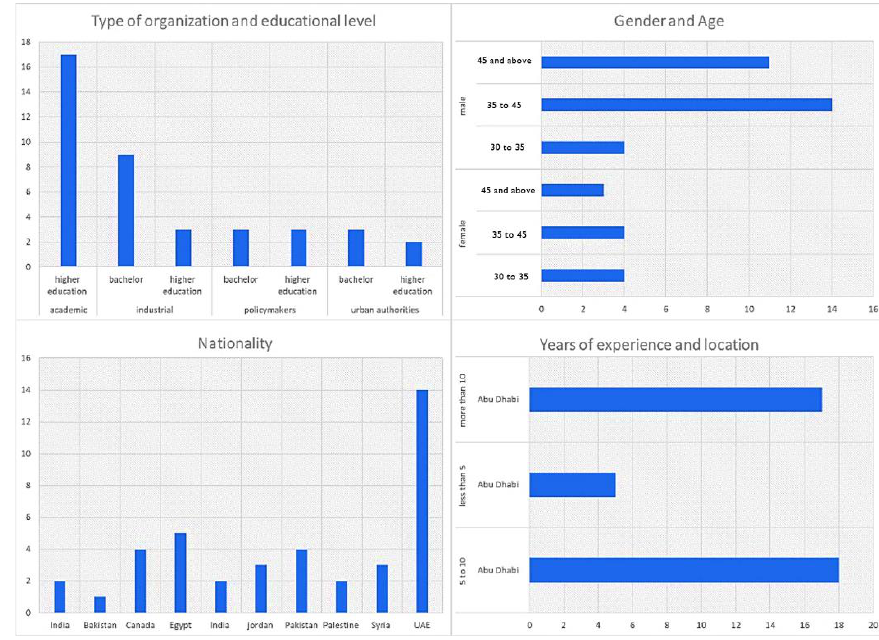
Figure 7. Participant social-demographic portrait.